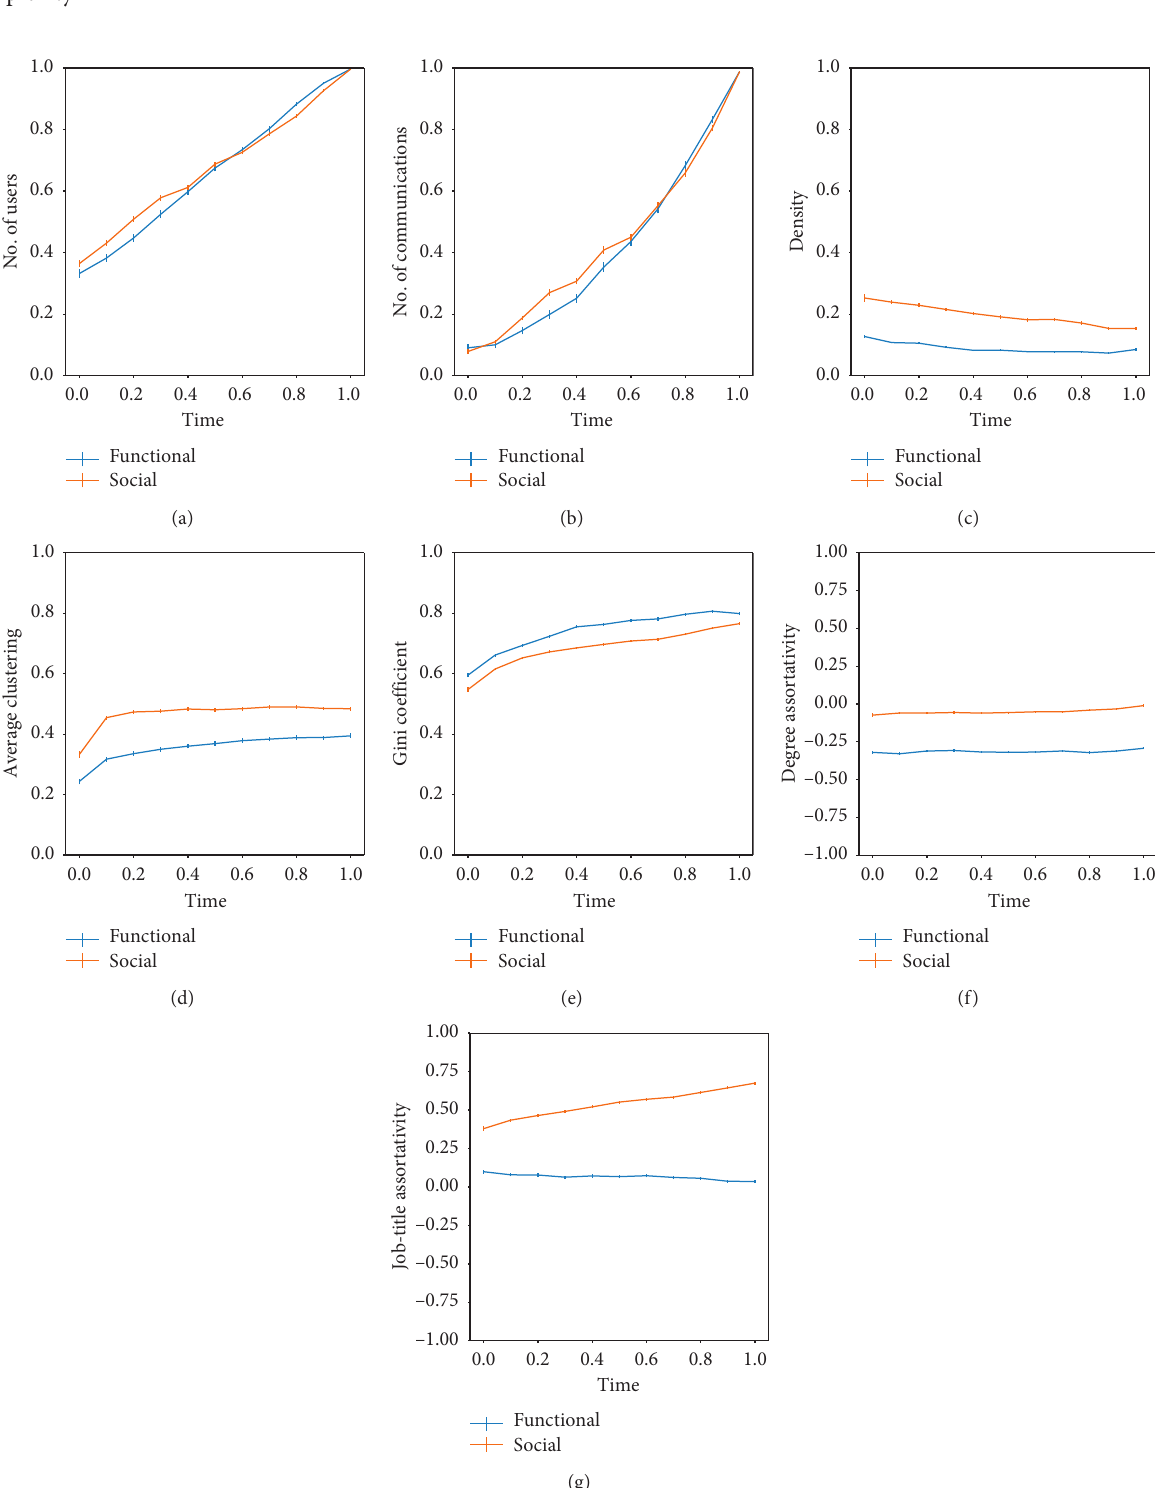
Figure 8: Dynamics of properties of functional (blue) and social (orange) networks for all enterprises. (a) No. of users per functional and social networks over time. (b) No. of communications per functional and social networks over time. (c) Density per functional and social networks over time. (d) Average clustering per functional and social networks over time. (e) Gini coefficients for functional and social networks’ degree distributions over time. (f) Degree assortativity for functional and social networks over time. (g) Job-title assortativity for functional and social networks over time. Error bars indicate the standard